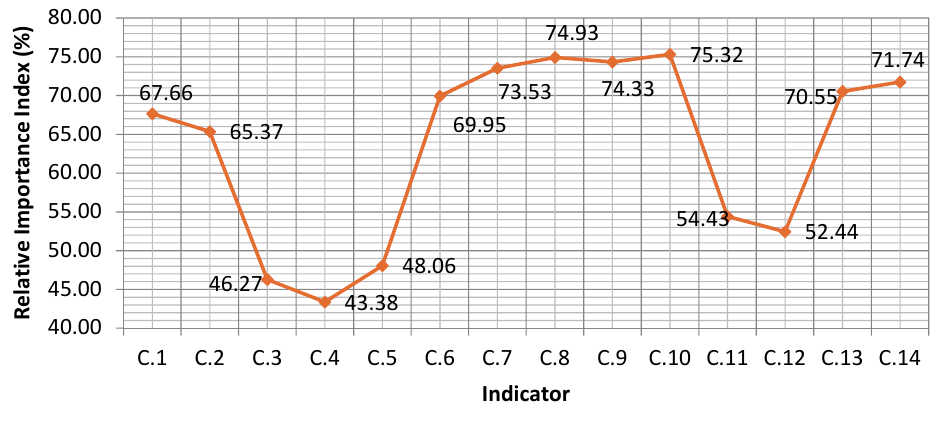
Fig. 1. Line chart of Relative Importance Index (RII) for understanding of KM